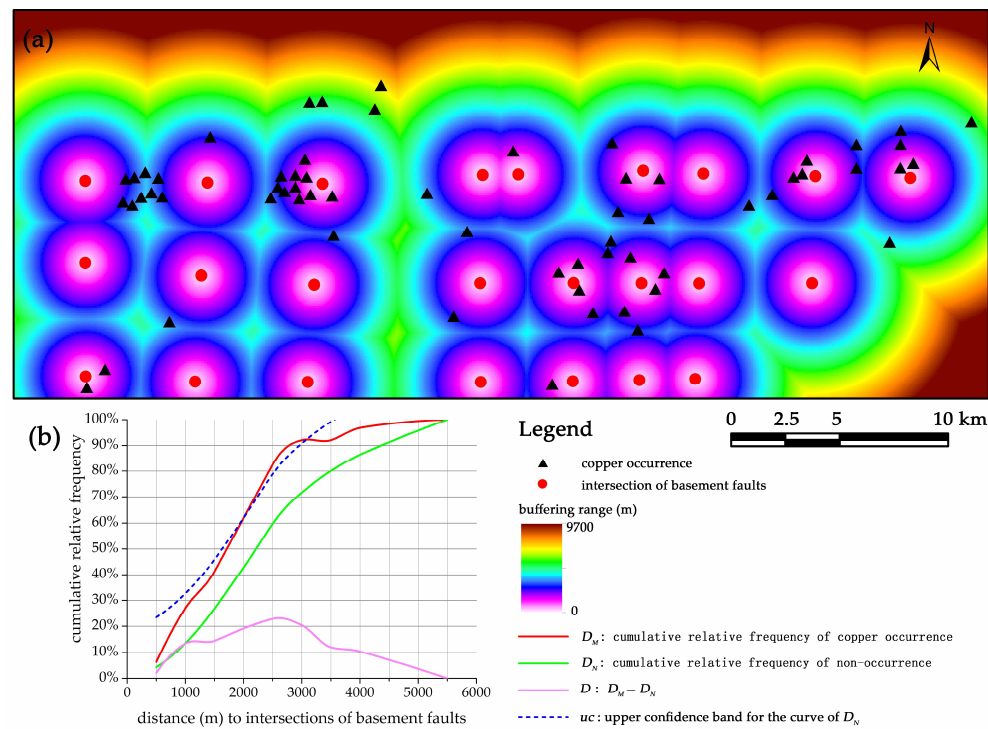
Figure 8. ( a ) Buffer analysis and ( b ) graph of cumulative relative frequency concerning distance to intersections of basement faults. Minerals 2018 , 8 , x FOR PEER REVIEW